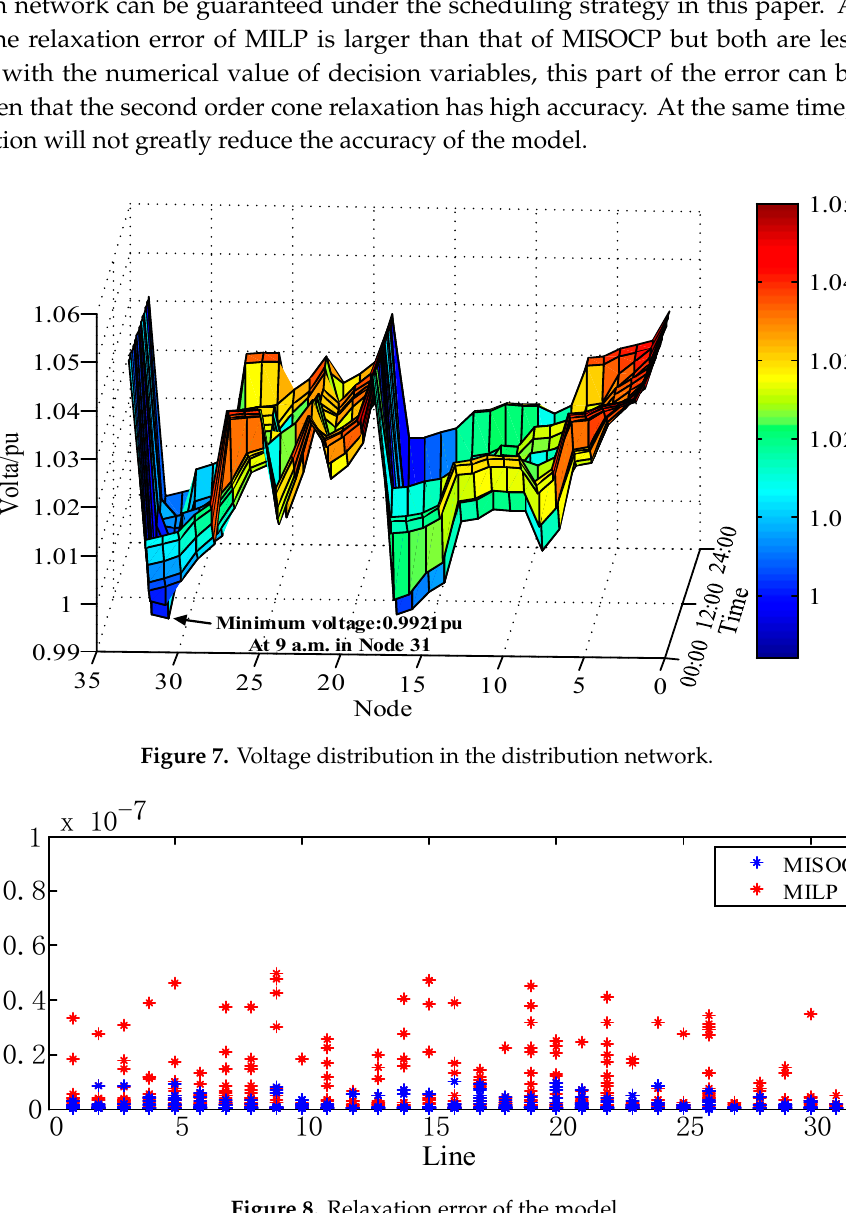
Figure 8. Relaxation error of the model.